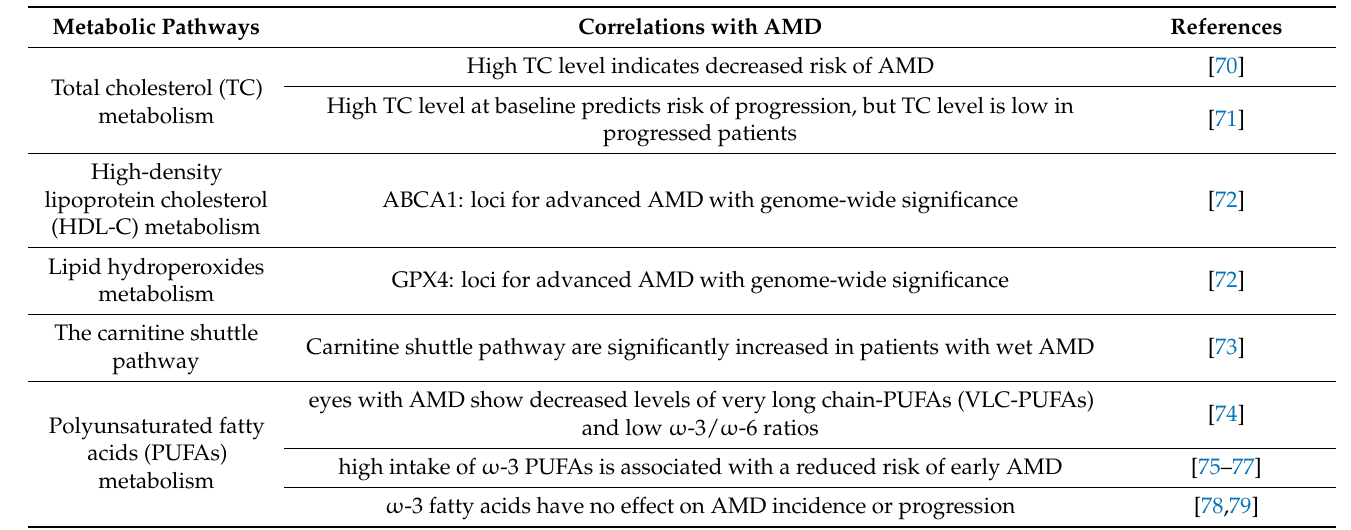
Table 1. Main metabolic pathways and their correlations with